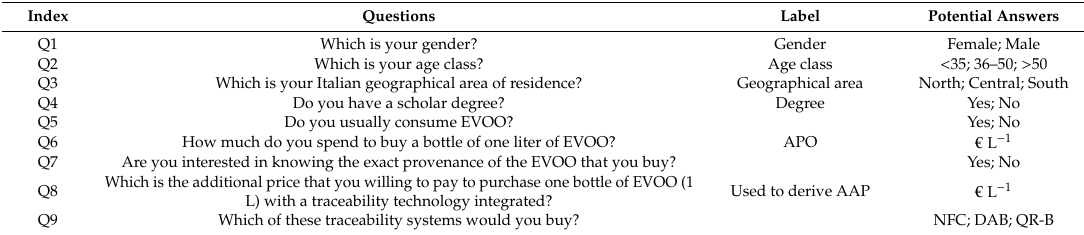
Table 2. Questionnaire format implemented in Microsoft Forms.